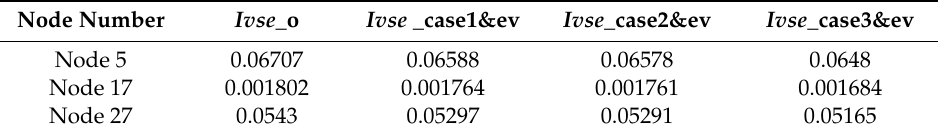
Table 4. Index value of Ivse with electric vehicle.